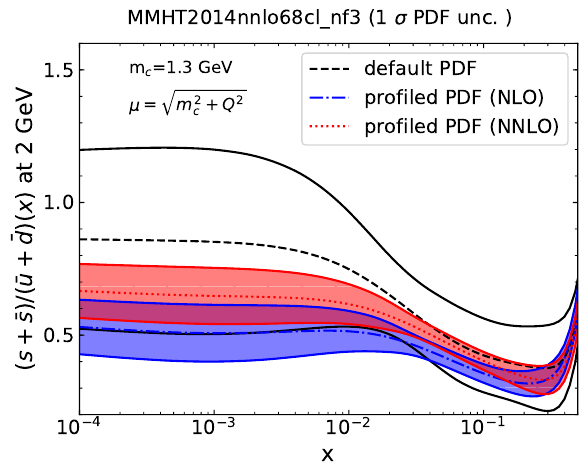
Figure 12 . Similar as (cid:12)gure 11 for pro(cid:12)ling of the MMHT2014 NNLO